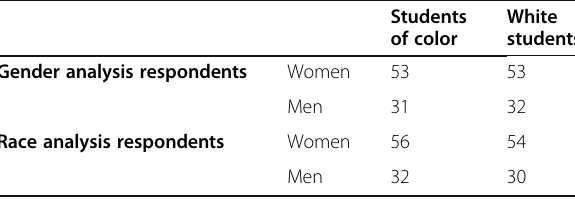
Table 2 Gender and race demographics of respondents coded for gender and race analysis